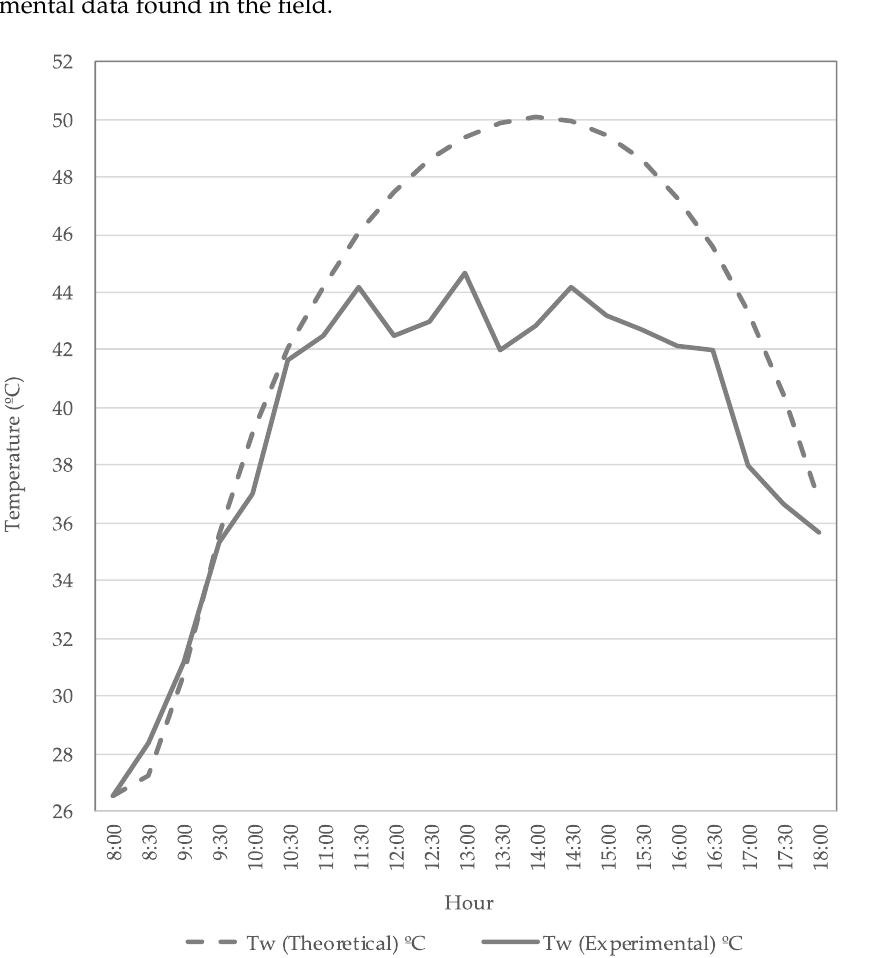
Table 6. Results of the statistical indicators used to evaluate the general adjustment of the model.